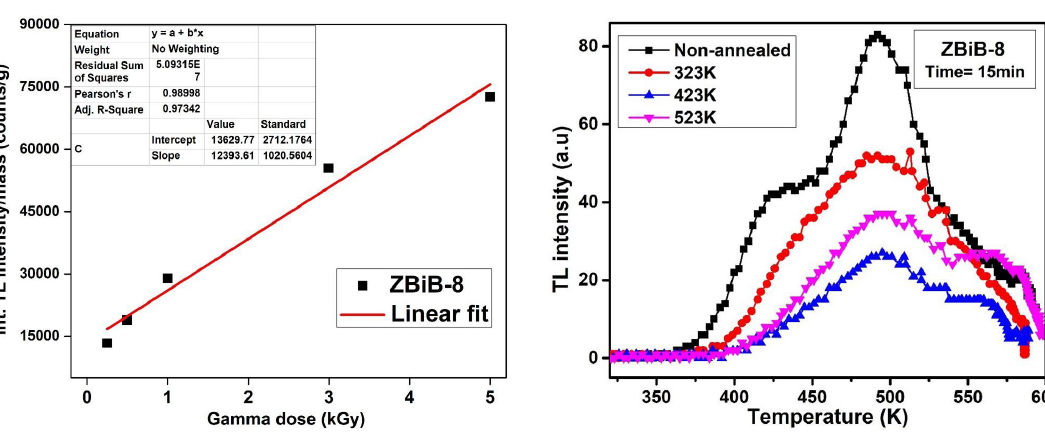
Figure 12. Plot of integrated TL intensity per unit mass for ZBiB-8 glass at gamma doses from 0.25- 5 kGy.